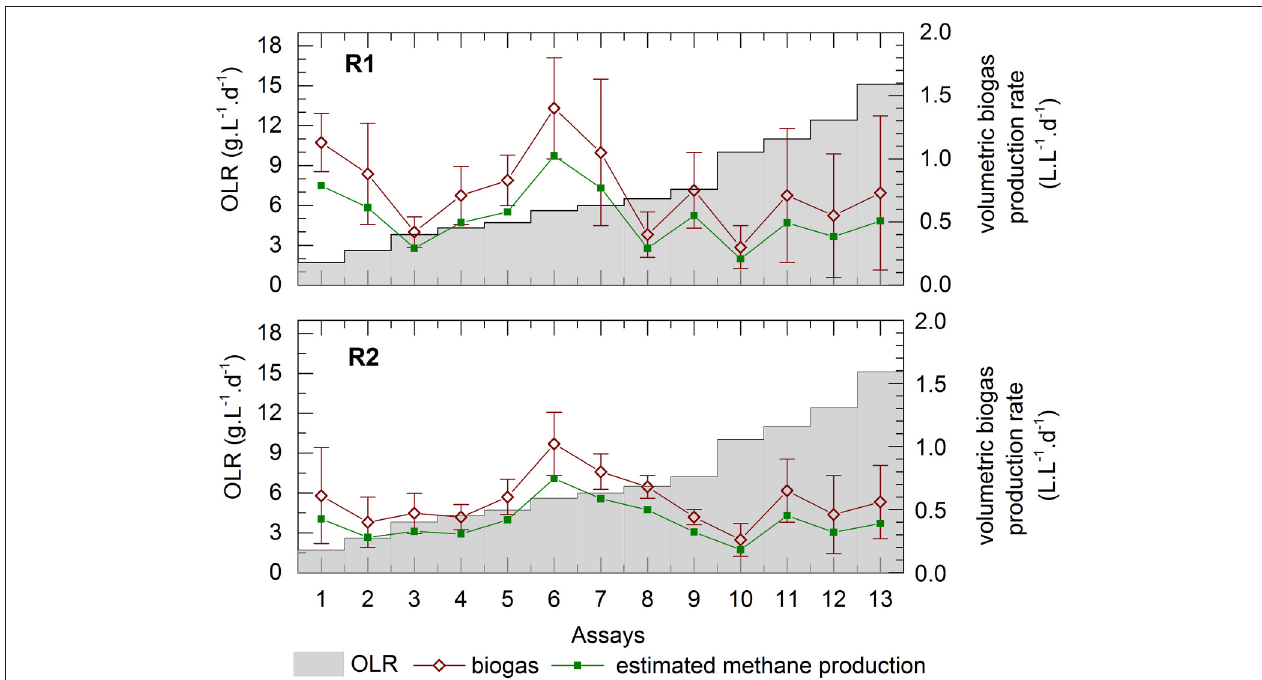
FIGURE 3 | Volumetric biogas production rate and estimated methane production in the reactors R1 and